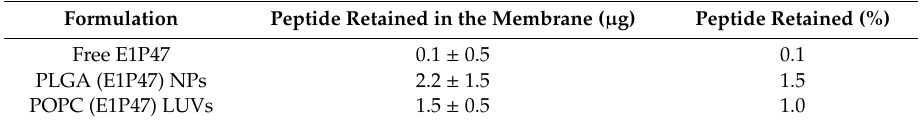
Table 3. Quantification of the peptide retained in the membrane used in the in vitro drug release assays.